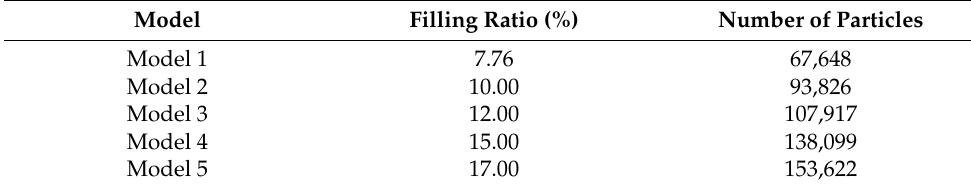
Table 1. Information of the SPH models for even keel